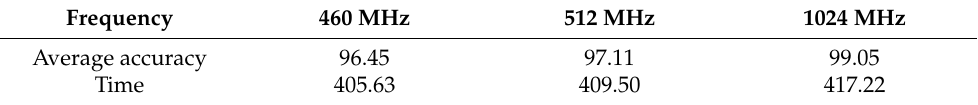
Table 9. The average accuracy (%) and training time (s) of DRSN at different sampling frequencies.